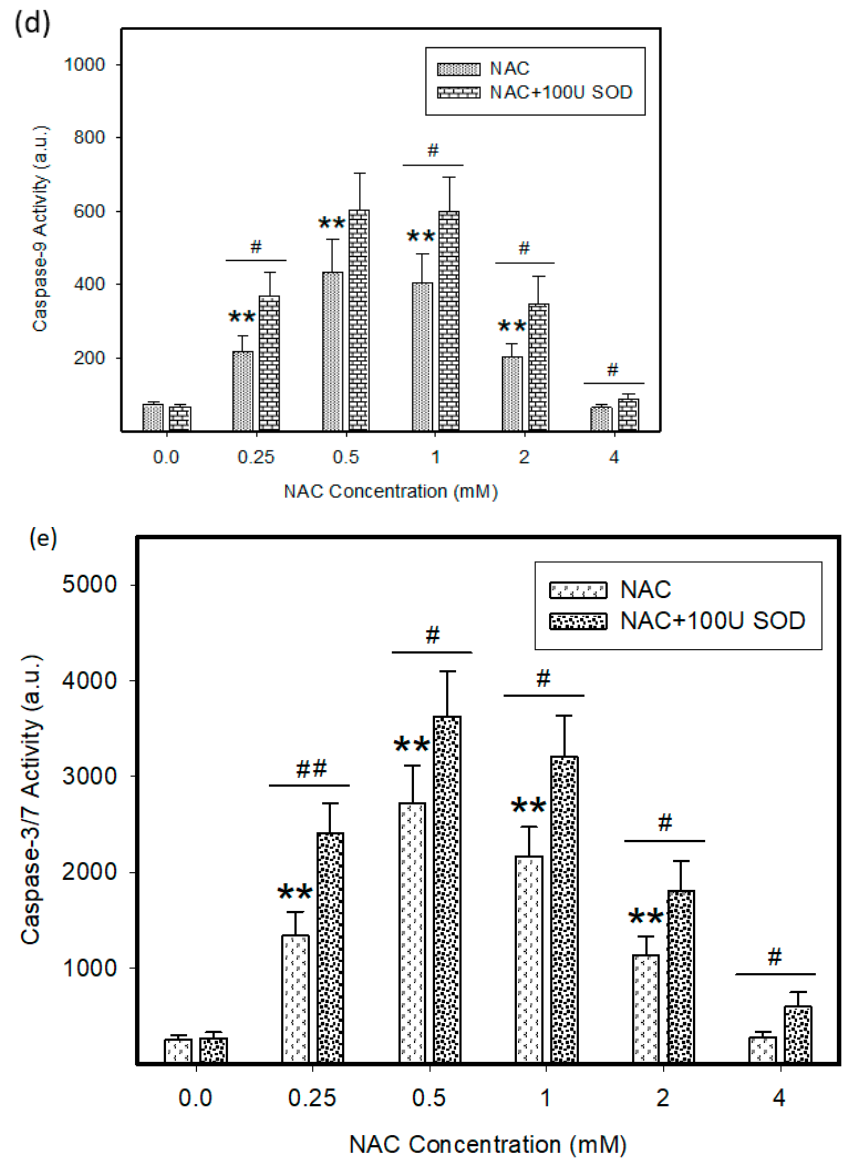
Figure 7. Effect of NAC on cell death features in HL-60 cells. Cells were treated with NAC or with NAC in combination in SOD as indicated. After 24 h incubation, cell death features were analyzed. ( a ) Effect on nuclear morphology. Pictures represent typical examples. ( b ) Effect on nuclear morphology—a quantitative analysis. Points represent mean from three independent experiments with standard deviations. ( c ) Effect on DNA fragmentation (hypodiploid DNA content). Histograms represent typical examples. ( d ) Effect on caspase-9 activation. Points represent mean from three independent experiments with standard errors. ( e ) Effect on caspase-3/7 activation. Points represent mean from three independent experiments with standard errors. ** denotes very significant difference in the caspase activity ( p < 0.05/ p < 0.01) between the NAC treated and untreated (control) cells. # / ## denotes significant/very significant difference in the caspase activity ( p < 0.01) between the indicated treatments.